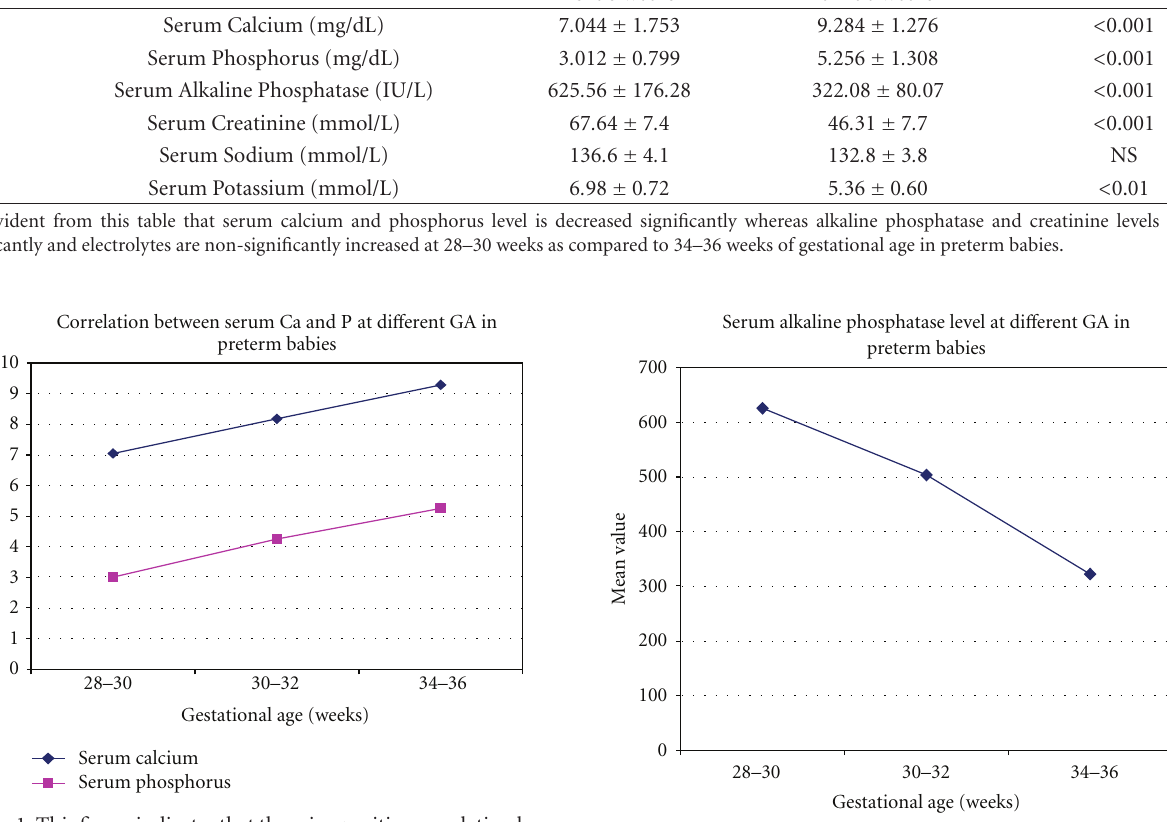
Figure 1: This figure indicates that there is a positive correlation be- tween serum calcium & phosphorus levels. The values are increases parallel with the advancement of GA. Figure 2: This figure indicates that the activity of alkaline phos- phatase is decreases with the advancement of